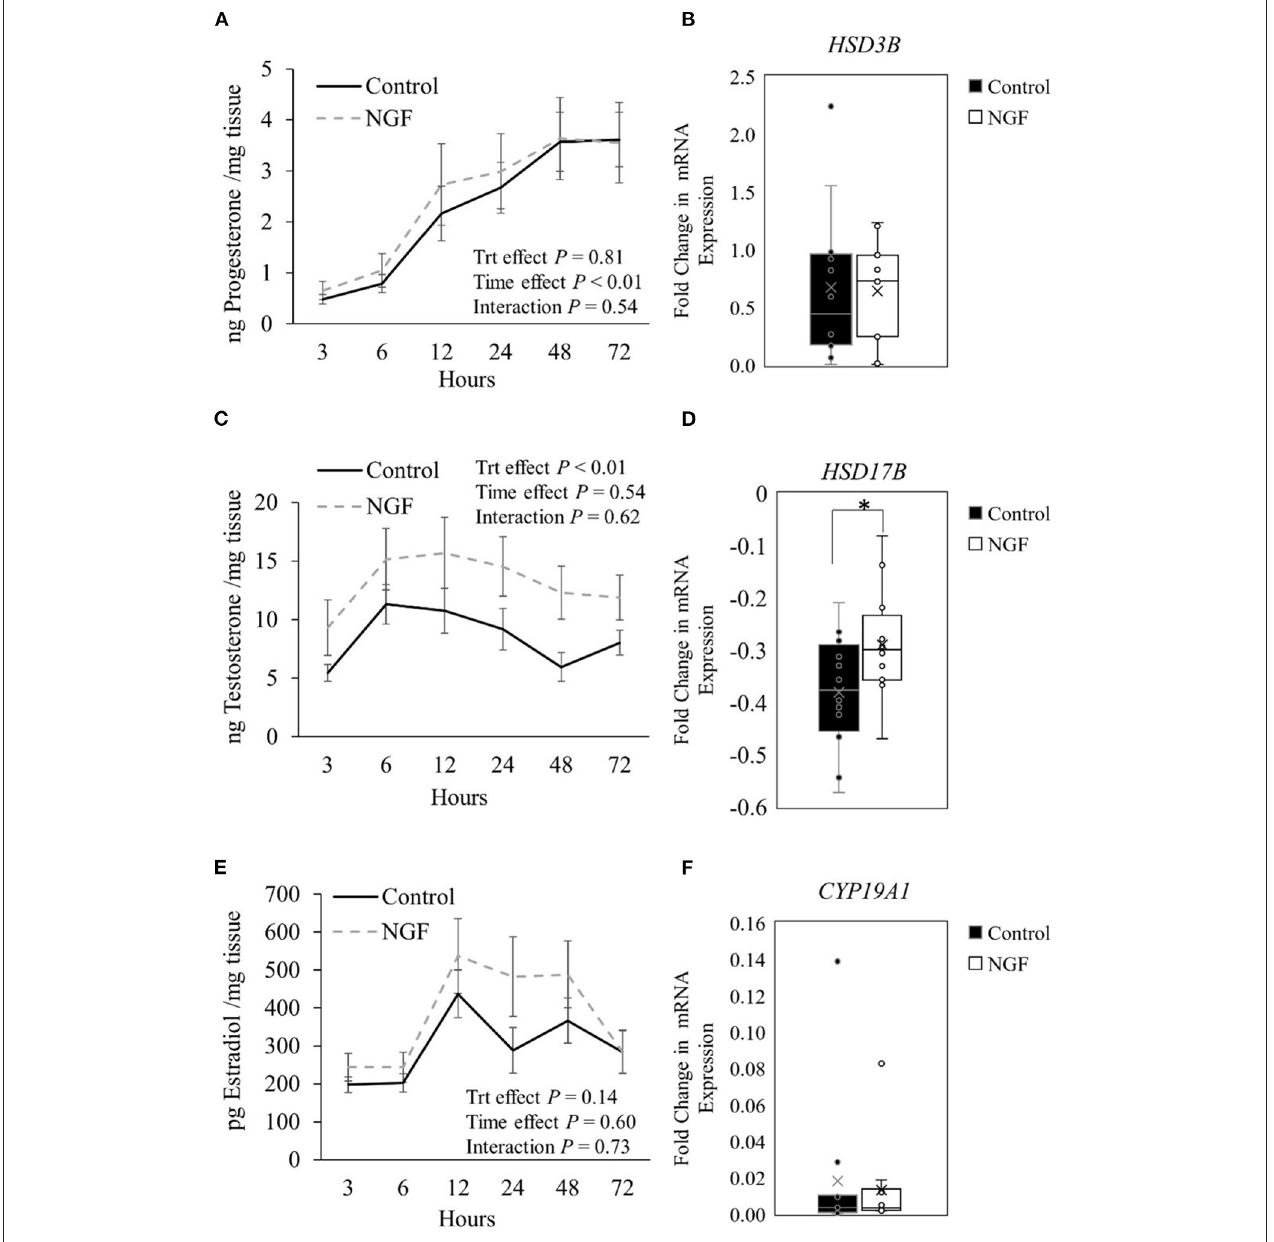
FIGURE 1 | Steroid hormone production (A,C,E) and steroidogenic enzyme gene expression (B,D,F) in follicle wall cells untreated (control) or treated with 100ng/mL NGF for 72h. Hormones are presented as mean ± SEM, whereas genes are presented as box-and-whisker plots. * P ≤ 0.05.